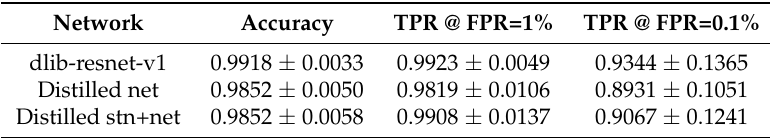
Table 2. Comparative results of the LFW identity verification test. Each row provides the figure for each model, the former ‘dlib resnet-v1’ and our two distilled model, ‘distilled net’ and ‘distilled net+stn’. The first column shows the resulting accuracy, while the last two columns provide the TPR value on the ROC curve (Figure 9) corresponding to an imposed FPR value of choice.